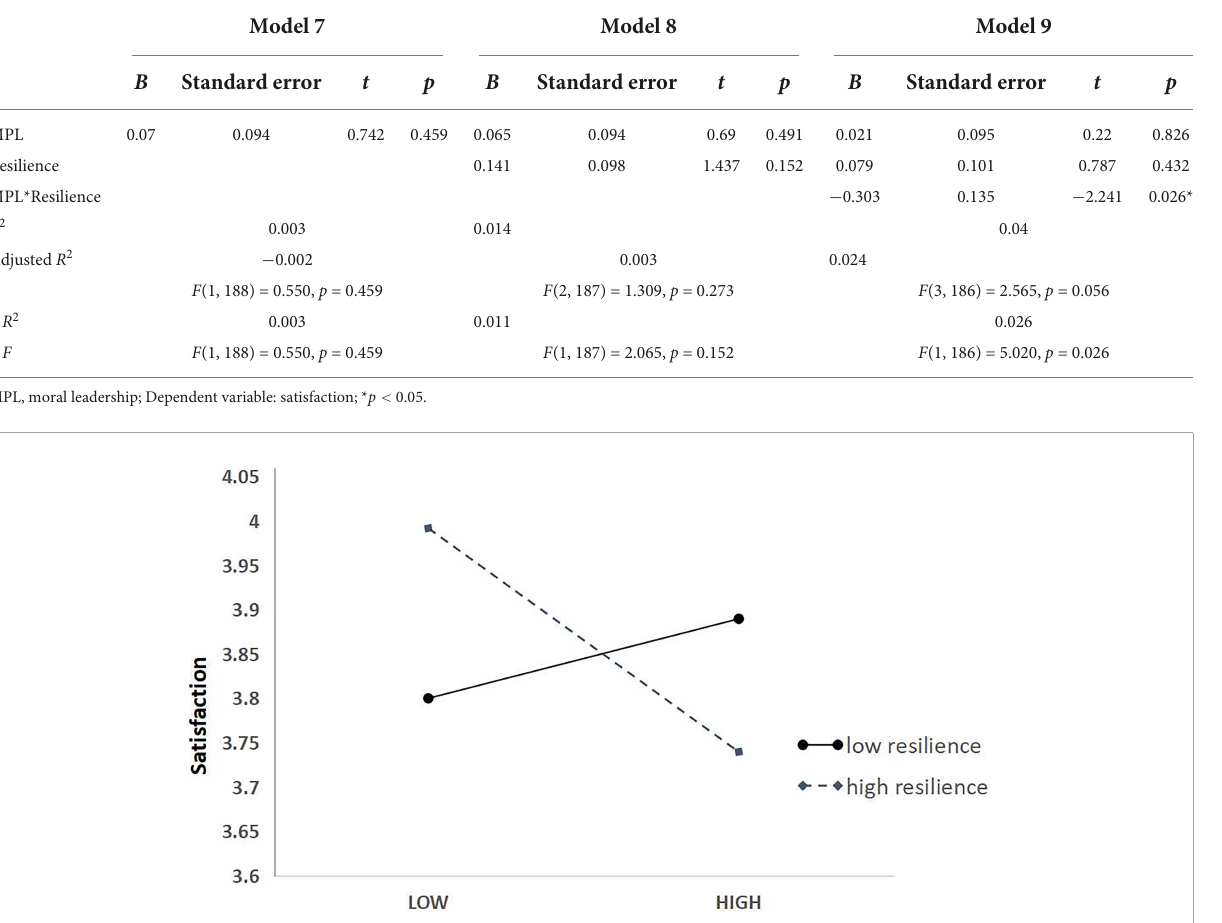
TABLE 2 Moral leadership moderating effect analysis results ( N = 190).